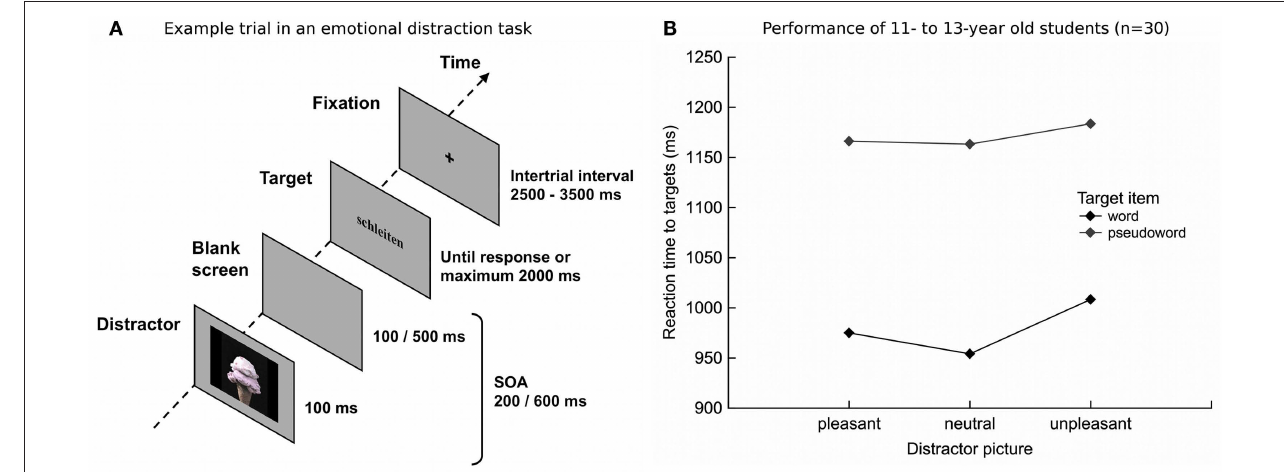
screen until the student responded, but no longer than 2000 ms post-target onset. After a variable intertrial interval of 2500–3500 ms and showing a fixation cross, the next sequence started. (B) Mean reaction time to verbal targets (in ms) as a function of distractor picture and target item in 30 early adolescents. Emotionally intense (pleasant and unpleasant) distractor images impaired decisions about word, but not pseudoword,